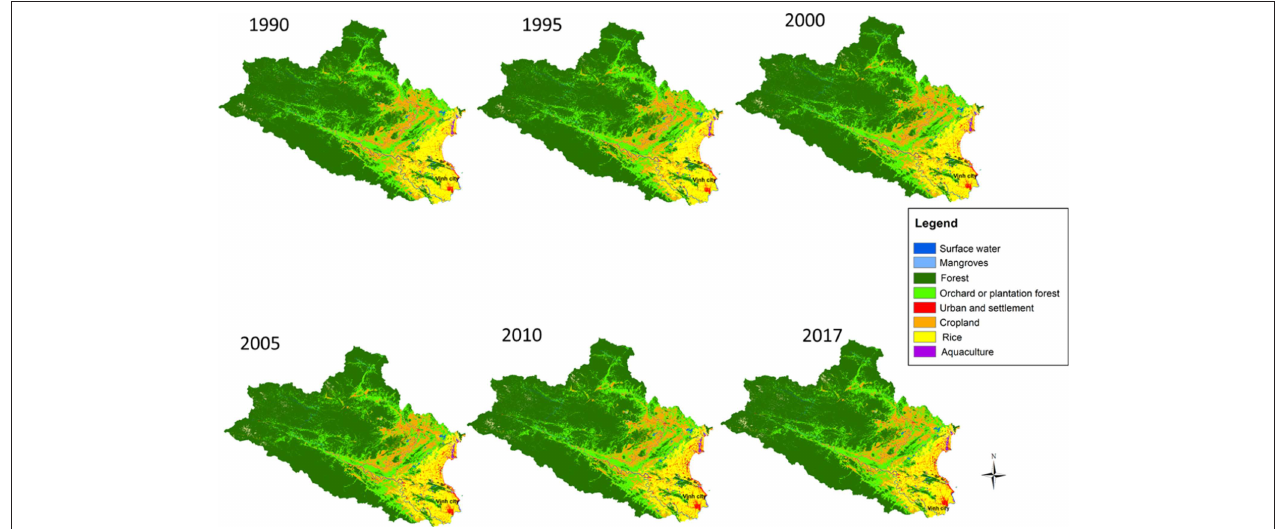
FIGURE 11 | Land cover change in Nghe An with 5 year intervals from 1990 to 2017. The statistics can be found in Supplementary Table 5